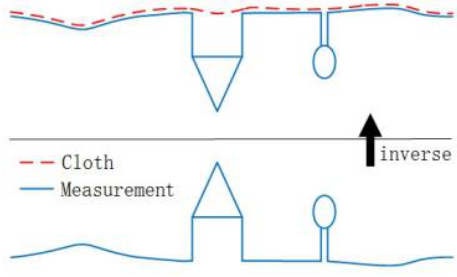
Figure 2. Overview of the cloth simulation algorithm (Zhang et al., 2016)